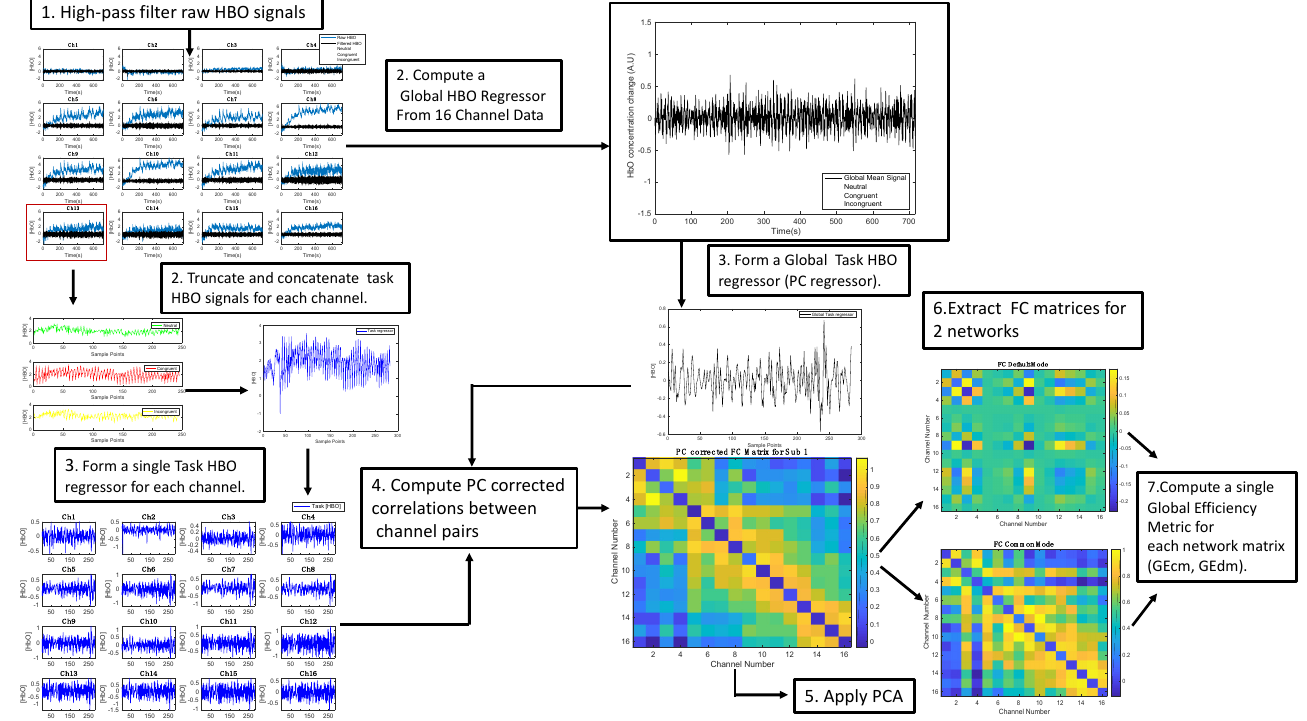
Figure 4. Pipeline for extracting fNIRS derived features.